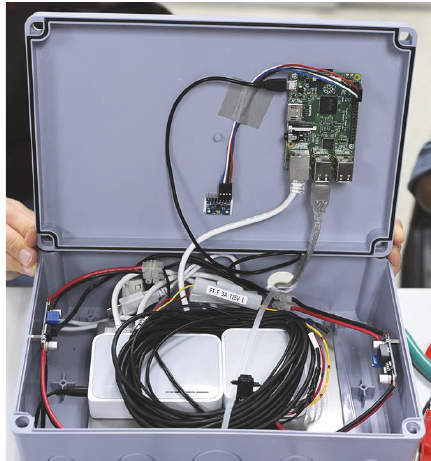
Figure 1: Equipment box attached in each vehicle.